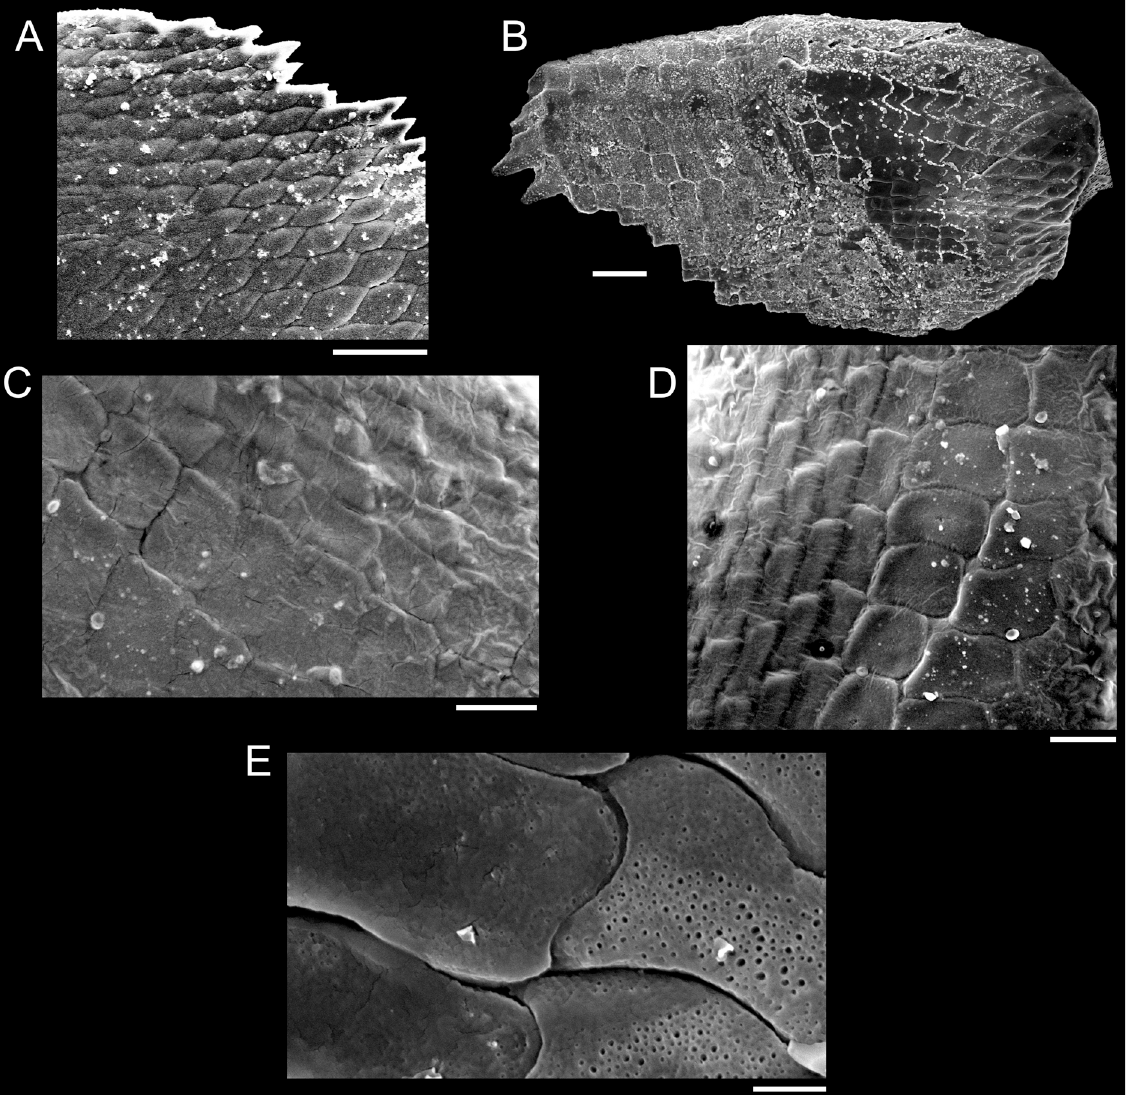
Fig. 10. Iniforis pseudothomae Rolán & Fernández-Garcés, 1993. A–E . Jaw, inner (A) and outer (B–E) sides. A–B, E . MZSP 100957. C–D . MNRJ 32881. Scale bars: A–B = 20 µm; C–D = 10 µm; E = 2